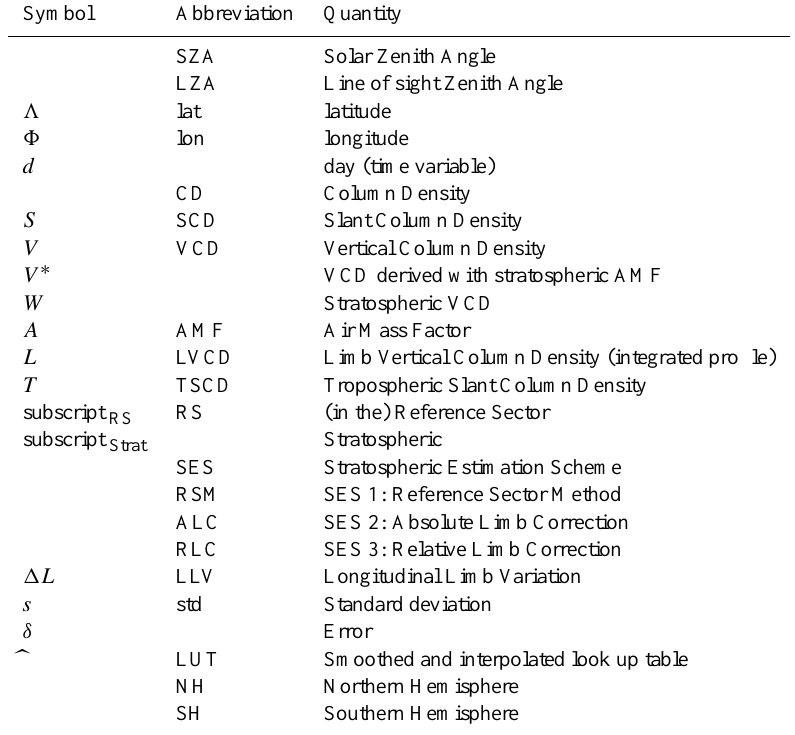
Table 1. Abbreviations and Variables used in this